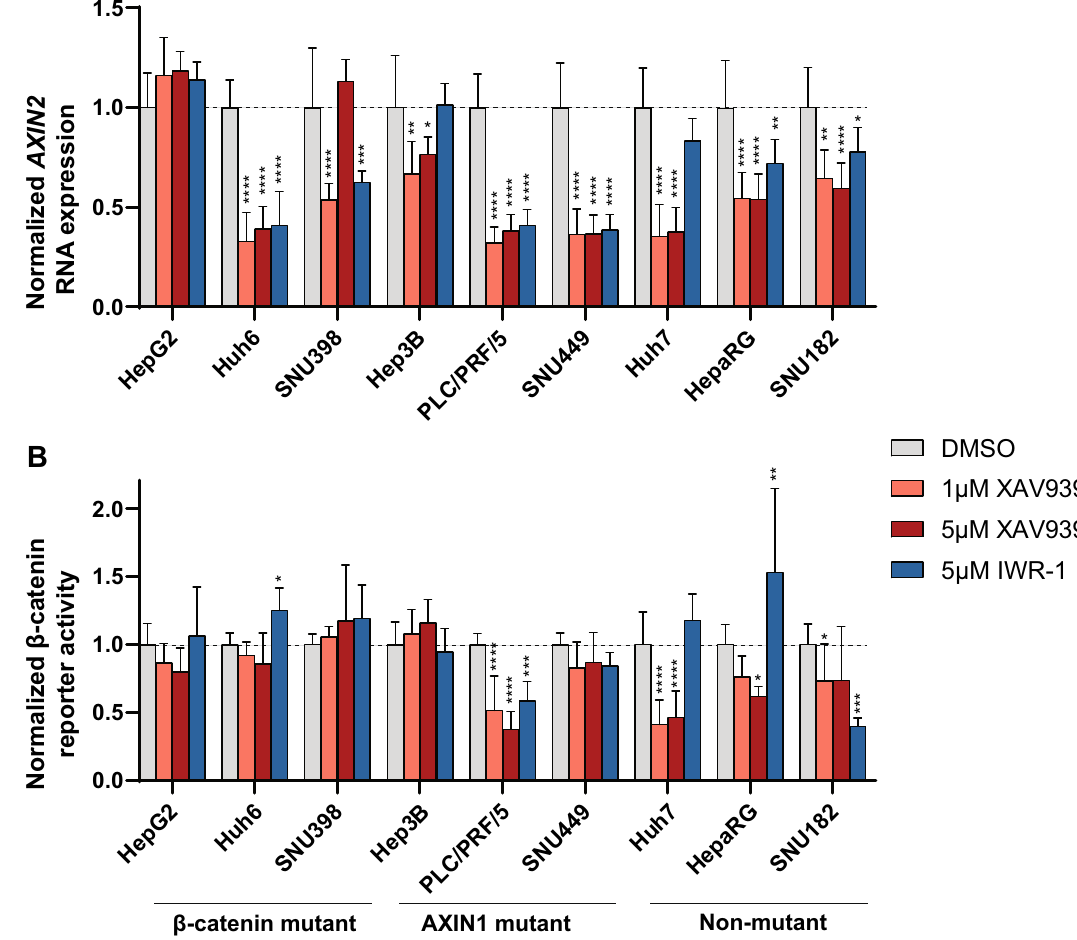
Figure 4. Effect of tankyrase inhibition on Wnt/β-catenin signaling. HCC cell lines were incubated with 1-5 μM XAV939 or 5 μM IWR-1, followed by an AXIN2 qRT-PCR or a β-catenin reporter assay. ( A ) Fold changes in AXIN2 expression levels depicted relative to the DMSO control-treated samples, which are arbitrarily set to 1. Only significant changes (unpaired t-test) are shown (mean ± SD, n = 3, twice, *P < 0.05; **P < 0.01; ***P < 0.001; ****P < 0.0001; 24 h treatment). ( B ) WRE/CMV-Renilla β-catenin reporter ratios were obtained for each cell line. Fold changes relative to the DMSO control-treated samples are shown, which are arbitrarily set to 1. Only significant changes (unpaired t-test) are shown (mean ± SD, n = 3, *P < 0.05; **P < 0.01; ***P < 0.001; ****P < 0.0001; 48 h treatment). See also Supplemental Fig. S8 showing absolute AXIN2 and β-catenin reporter levels and Supplemental Fig.